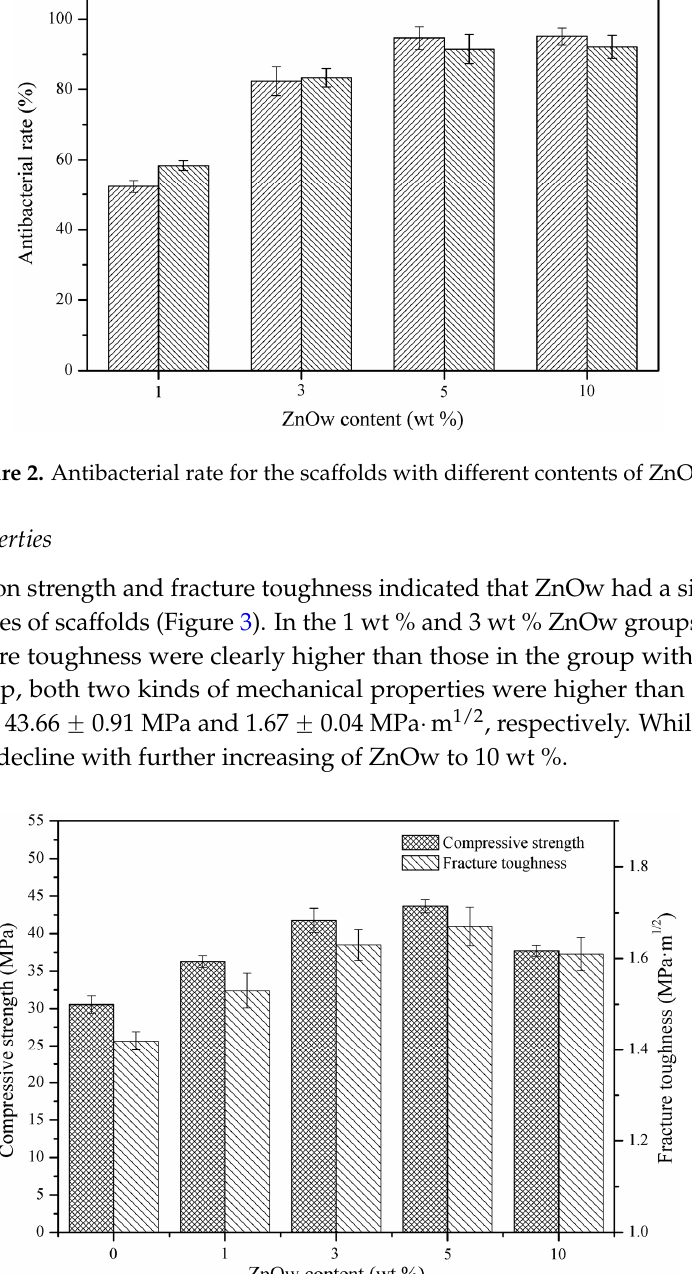
Figure 3. Compressive strength and fracture toughness of the scaffolds with different contents of ZnOw.